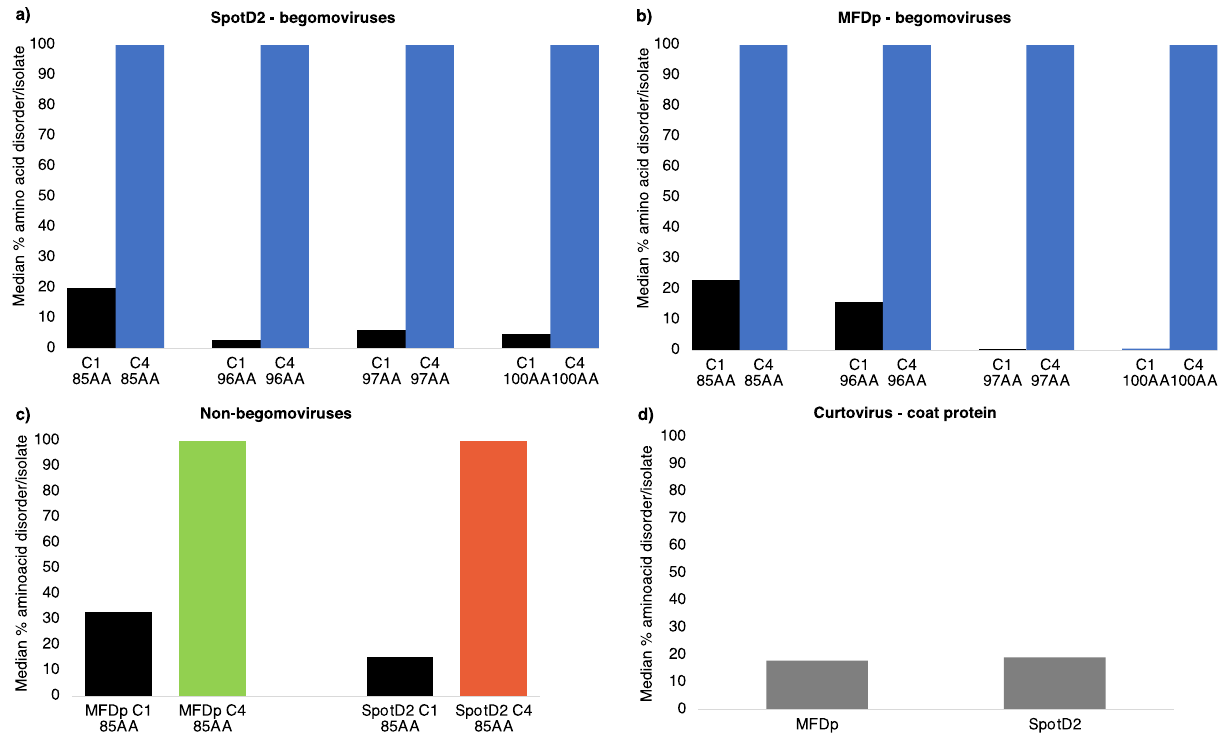
Figure 3. Intrinsically disordered protein analysis. ( a ) Medium percentage amino acid intrinsic disorder/ begomovirus isolate determined by SPOT-Disorder2 for C4(AC4) proteins and the overlapped C1(AC1) protein regions. ( b ) Medium percentage amino acid intrinsic disorder/begomovirus isolate determined by MFDp2 for C4(AC4) proteins and the overlapped C1(AC1) protein regions. For ( a ) and ( b ), 106 begomovirus isolates encoded C4(AC4) proteins and the corresponding C1(AC1) regions of 85 amino acids in length, 26 isolates of 96 amino acids in length, 37 isolates of 97 amino acids in length and 28 isolates of 100 amino acids in length (Supplementary Table S6). ( c ) SPOT-Disorder2 and MFDp2 analysis of encoded C4(AC4) proteins and the overlapped C1(AC1) protein regions of non-begomovirus isolates, 85 amino acids in length, that included the isolates from the Curtovirus , Turncurtovirus and Topocuvirus genera (Supplementary Table S6). ( d ) SPOT- Disorder2 and MFDp2 analysis of curtovirus coat proteins, 254 amino acids in length (Supplementary Table